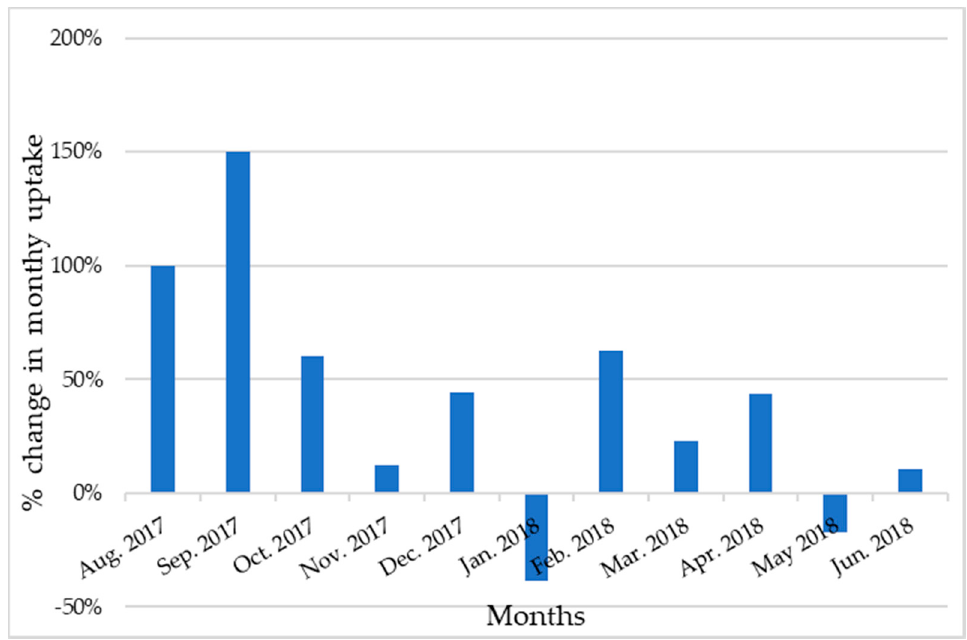
Figure 2. Percentage change in month by month variation in EWP uptake from the GWCL database.